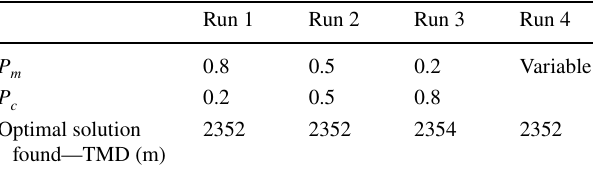
Table 3 Key GA behavioral parameters values applied to four runs and the optimal objective function value found after 2000 iterations